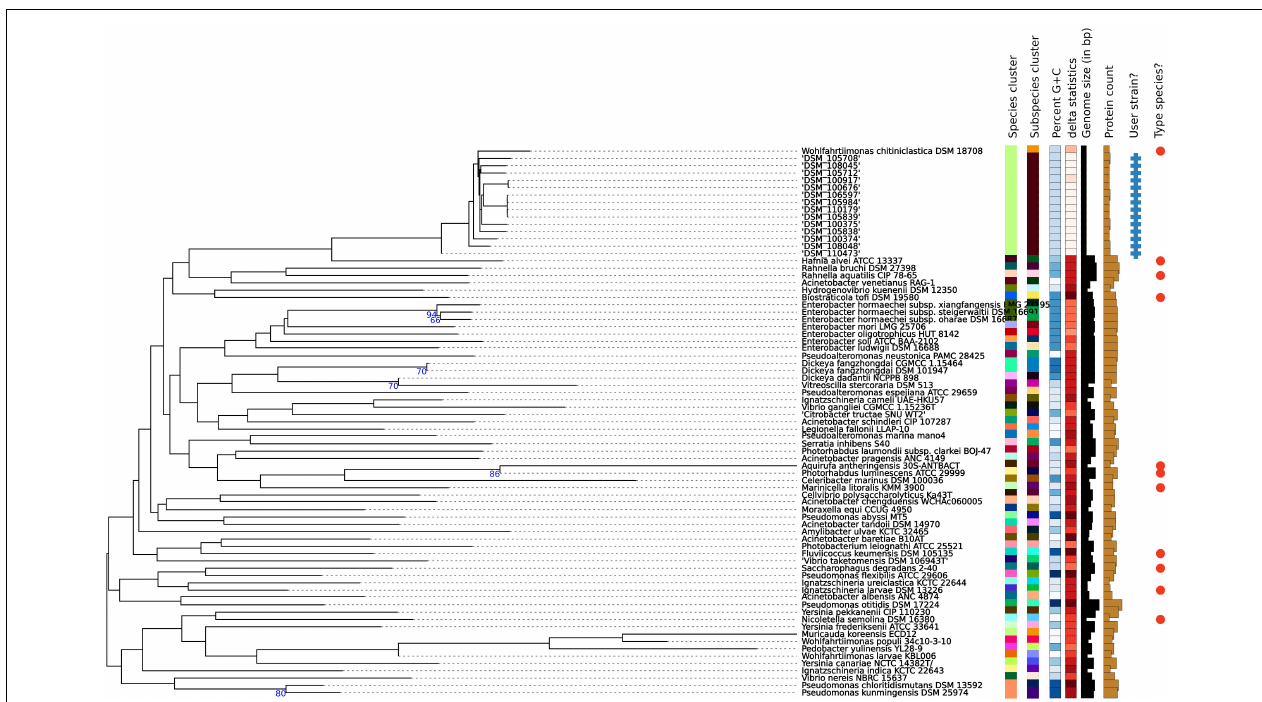
FIGURE 2 | Phylogenomic tree of the W. chitiniclastica species and subspecies delineation based on the GBDP phylogenetic analyses retrieved from the TYGS website. The tree was inferred with FastME 2.1.6.1 (Lefort et al., 2015) from GBDP distances calculated from genome sequences and was subjected to a clustering using established thresholds for delineating species (DDH > 70%) (Meier-Kolthoff et al., 2013a) as well as subspecies (DDH > 79%) (Meier-Kolthoff et al., 2014). The branch lengths are scaled in terms of GBDP distance formula d5. The numbers above branches are GBDP pseudo-bootstrap support values > 60% from 100 replications, with an average branch support of